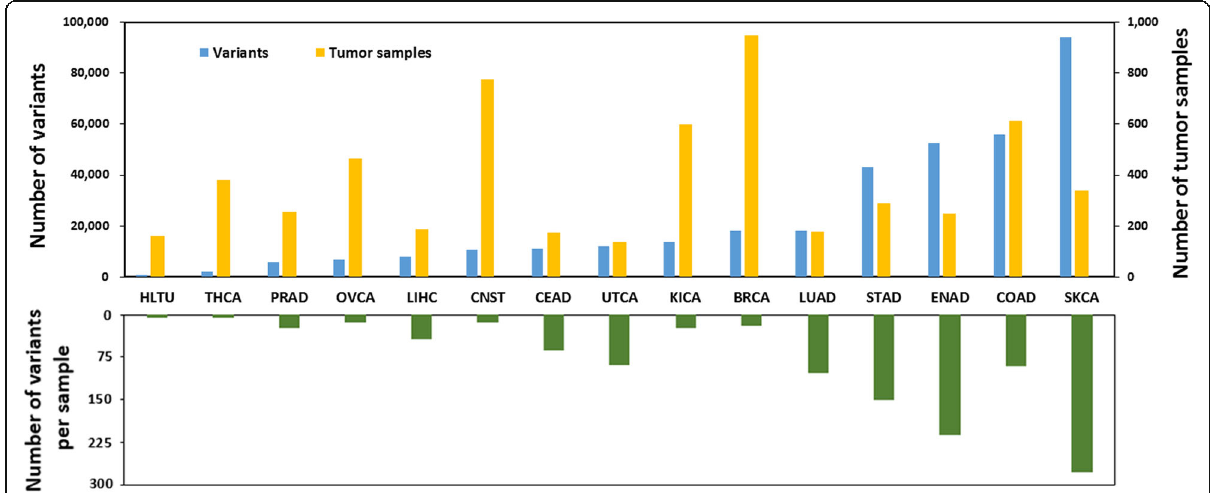
Fig. 1 Distribution of synonymous variants, tumor samples across different cancer types. Upper panel: blue and yellow bars represent the proportions of synonymous variants and corresponding tumor samples, respectively. Lower panel: Green bar represents the average numbers of variants per sample. The x-axis represents the cancer types